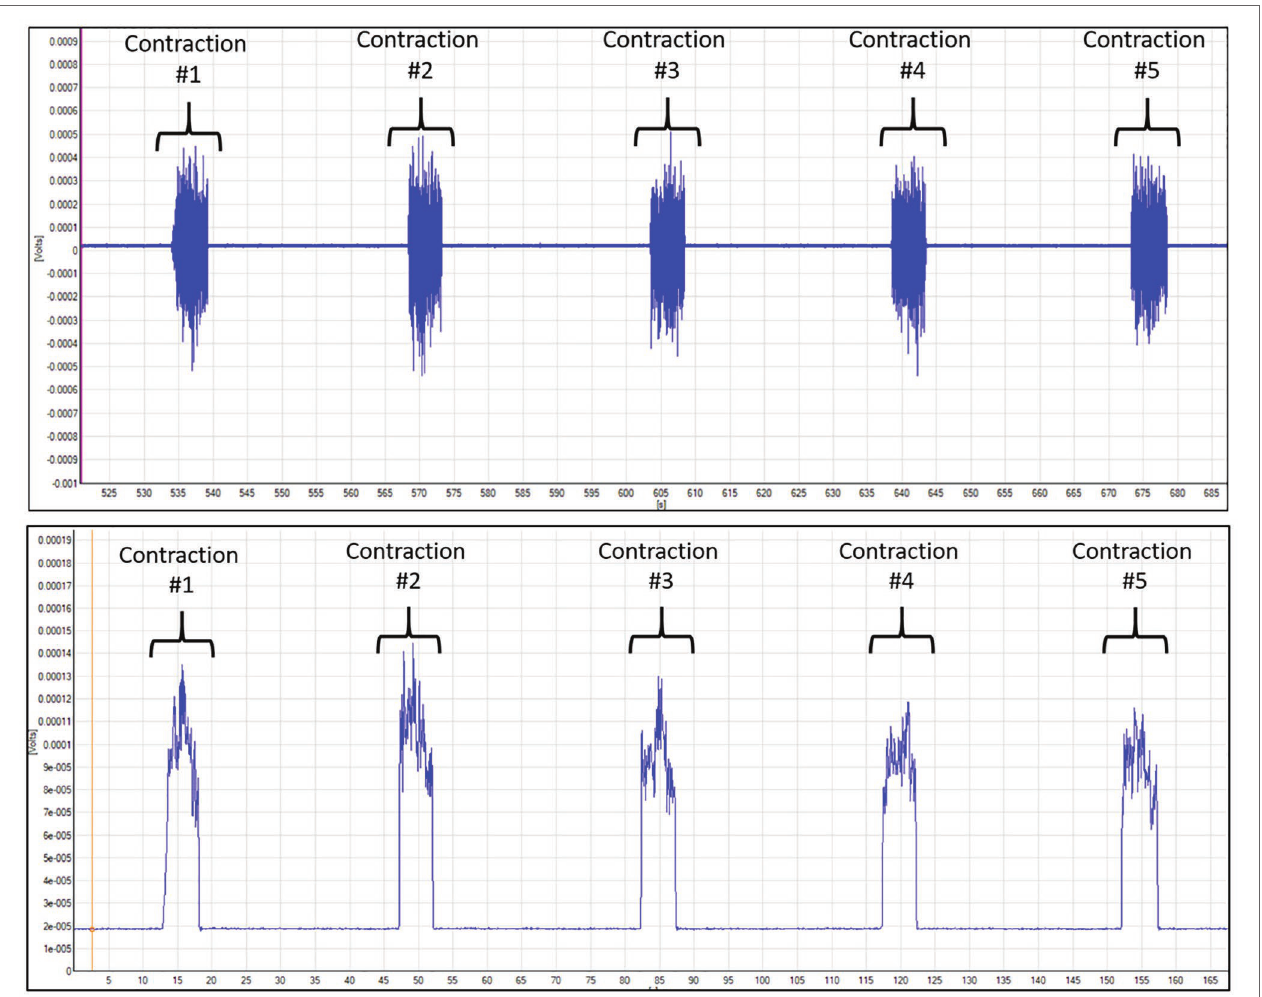
FIGURE 1 | Depiction of vastus lateralis SEMG data for MVIC knee extension. The blue line is the electrical signal collected by the SEMG sensor during the exercise. Top figure depicts the raw SEMG data. Bottom figure shows the data that were transformed using the root mean squared (RMS) script within the Delsys Acknowledge software. The RMS method transforms the raw data to calculate the neuromuscular amplitude during the